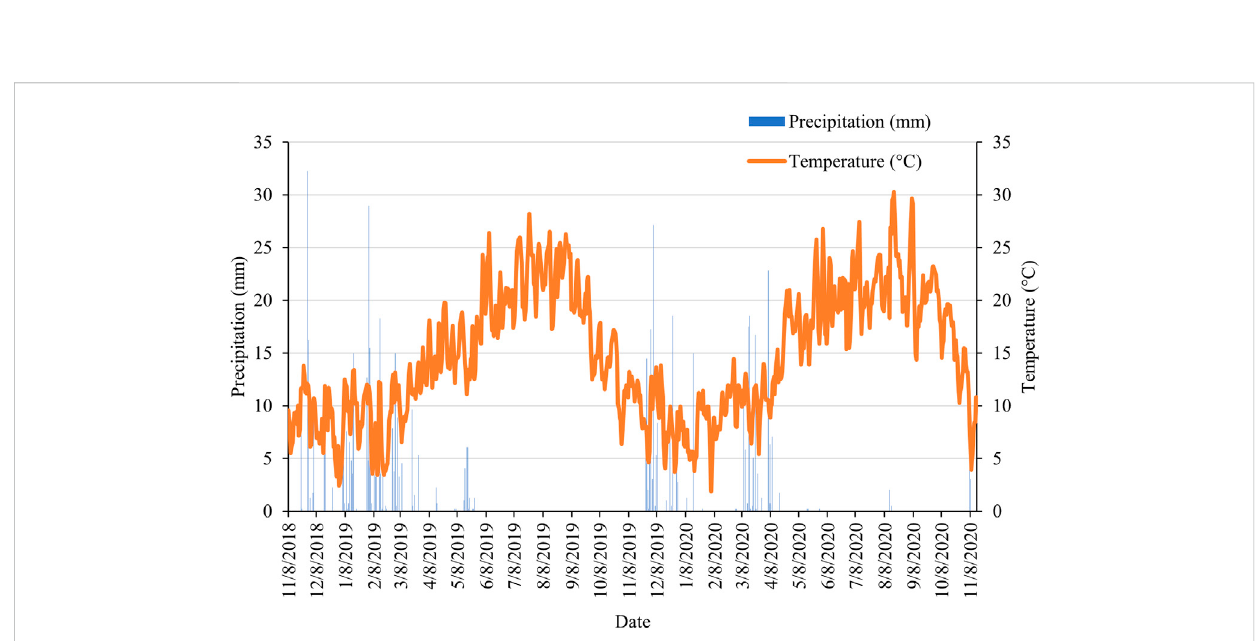
FIGURE 2 Precipitation and temperature recorded at the experimental site over the course of the